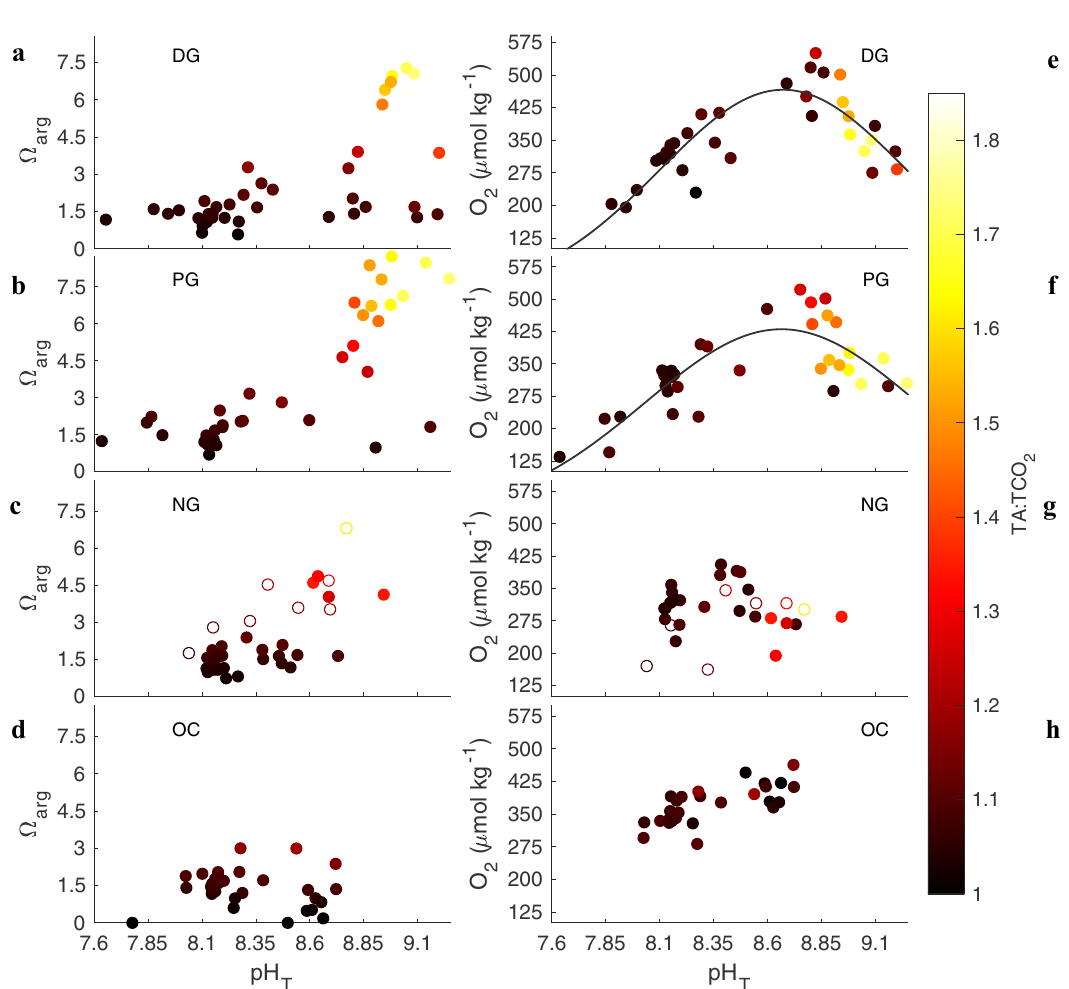
Figure 4. All sample points of Ω arg ( a – d ) and O 2 concentration ( e–h ) as a function of pH T for dense grass (DG), patchy grass (PG), no grass (NG), and ocean (OC). Color bar is the measured TA:TCO 2 ratio for each point in the timeseries. Gaussian fits applied to DG pool with an RMSE of 51.39 and 55.68 for the PG pool. Open circles in panels ( c ) and ( g ) indicate measurements taken after 24 June during NG pool